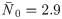
Steady-state distributions of population composition x for different initial conditions.The experimental distribution (bars) is the result of growth on 120 independent wells. We use the measured average x
0 and N
0 from the experiments to initialize the simulations of several 120-well ensembles. After growth, we compute the histogram for each of these ensembles and obtain the average theoretical distribution (blue line). Using the values from this distribution, we compute the three confidence intervals (shaded gray areas) for each bin for 68% (between dashed lines), 95% (between dotted lines) and 99.73% confidence. The two sets of data match: most experimental data agree with the first prediction confidence region, practically all with the second one. The limit distributions are clearly different from the initial ones (see S1 Fig). The importance of growth in changing the distributions depends on the initial size N
0 (see main text, and S1 Fig). Parameter values: N‾0=2.9, x‾0=0.32 (panel (a)); N‾0=18.4, x‾0=0.22 (panel (b)); N‾0=19.6, x‾0=0.52 (panel (c)); N‾0=14.5, x‾0=0.71 (panel (d)).